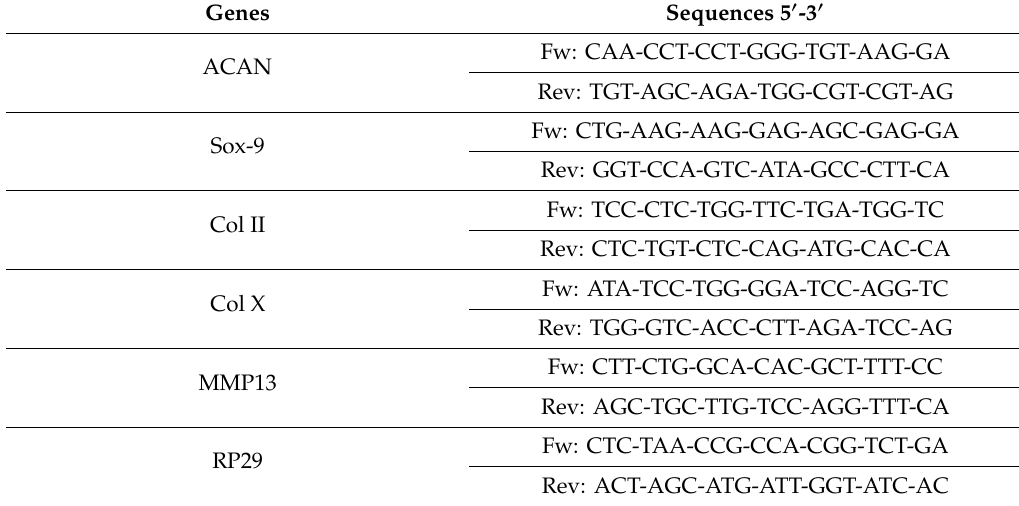
Table 1. Sequences of specific primers for RT-PCR